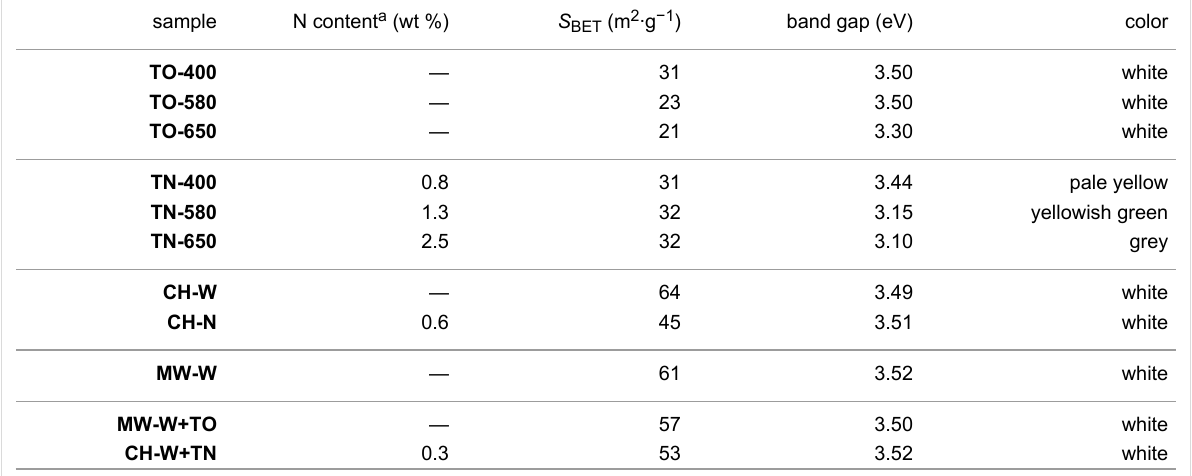
Table 2: Nitrogen content, specific surface area ( S BET ), band-gap energy values, and color of TiO 2 nanoribbons derived from hydrogen titanate nanoribbons under different transformation conditions.